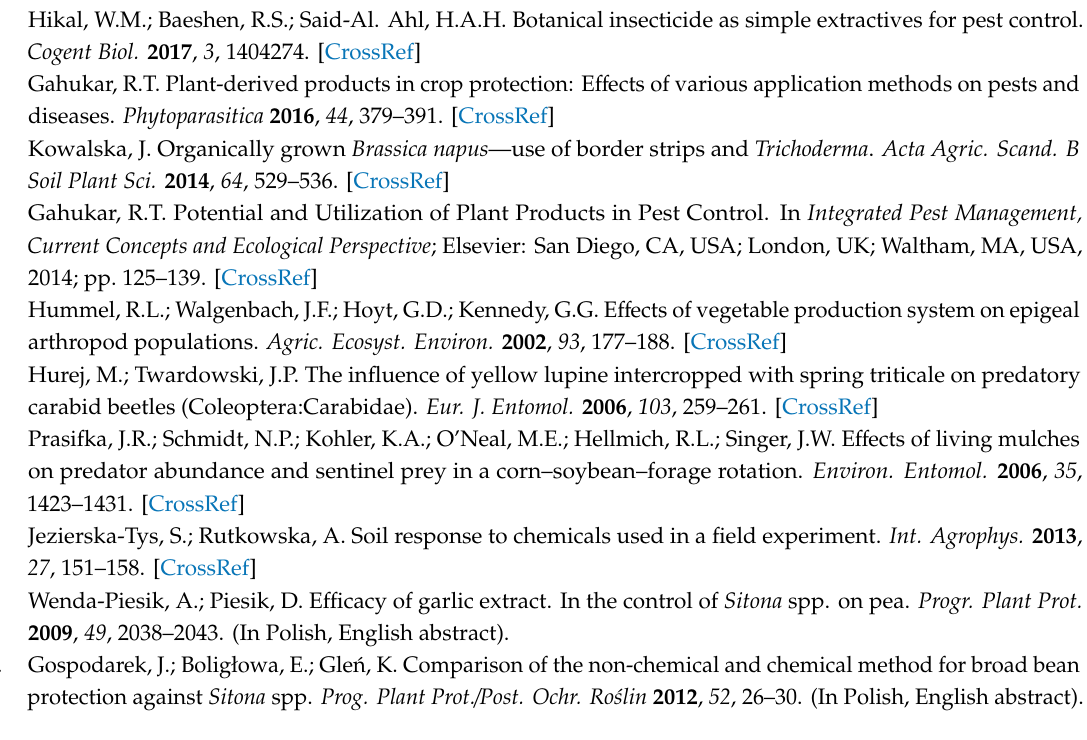
Table S1: The number and species composition of Carabidae in broad bean crop depending on the protection method used. Treatments as in Table 1, Table S2: Results of the statistical analysis of the presence of other Carabidae